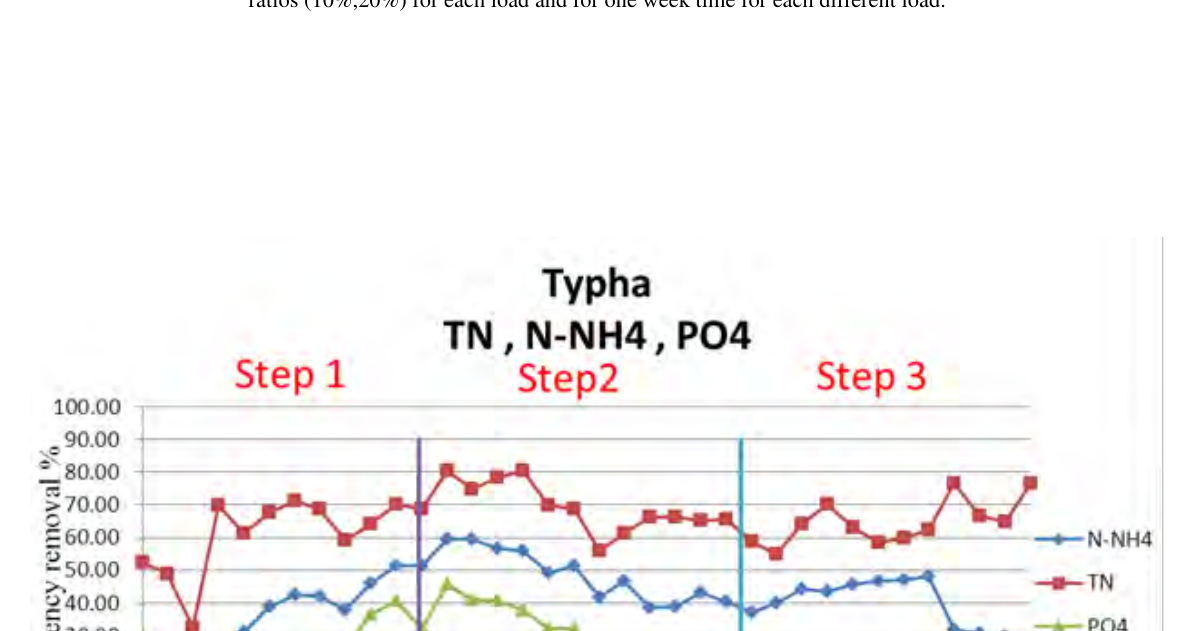
Figure 13. Efficiency removal of N-NO 3 IN Phragmate tanks during three surface loads(8,6,4)m 3 /m 2 .h and tow circulation ratios (10%,20%) for each load and for one week time for each different load.